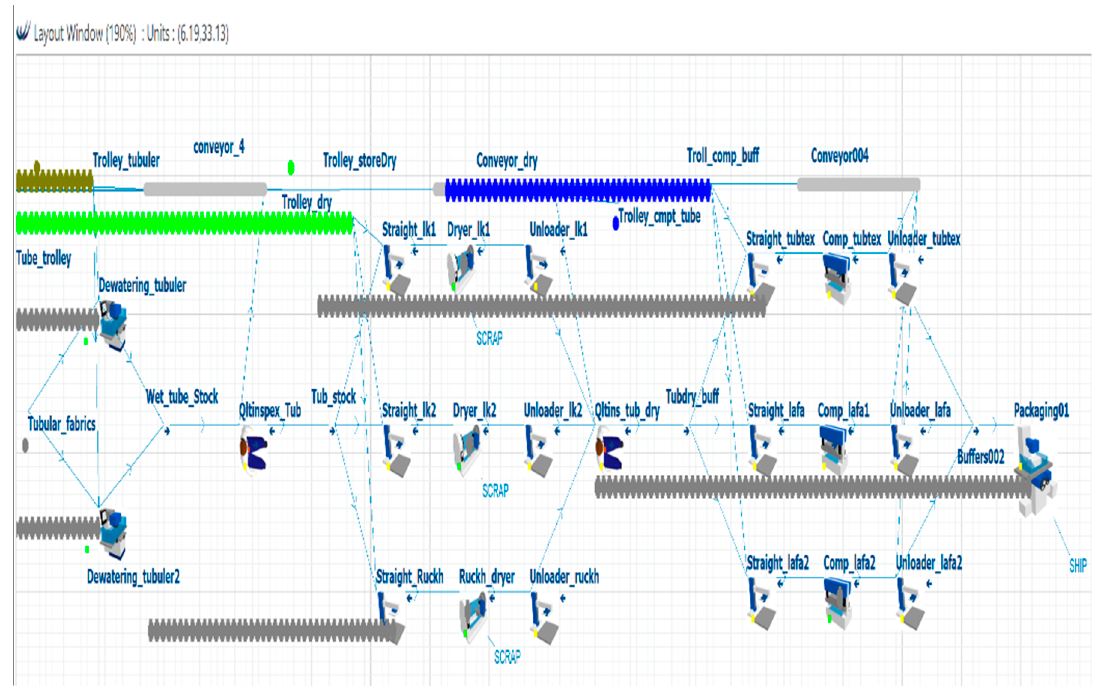
Figure 8. Optimization model.